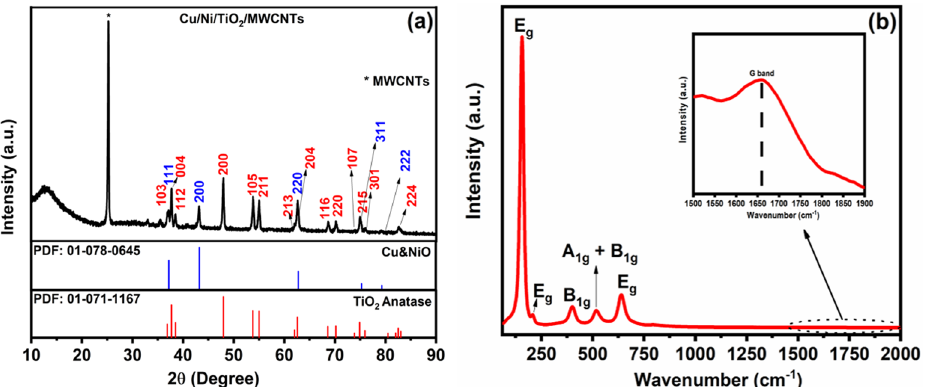
Figure 2. ( a ) XRD patterns, and ( b ) Raman spectra of Cu/Ni/TiO 2 /MWCNTs